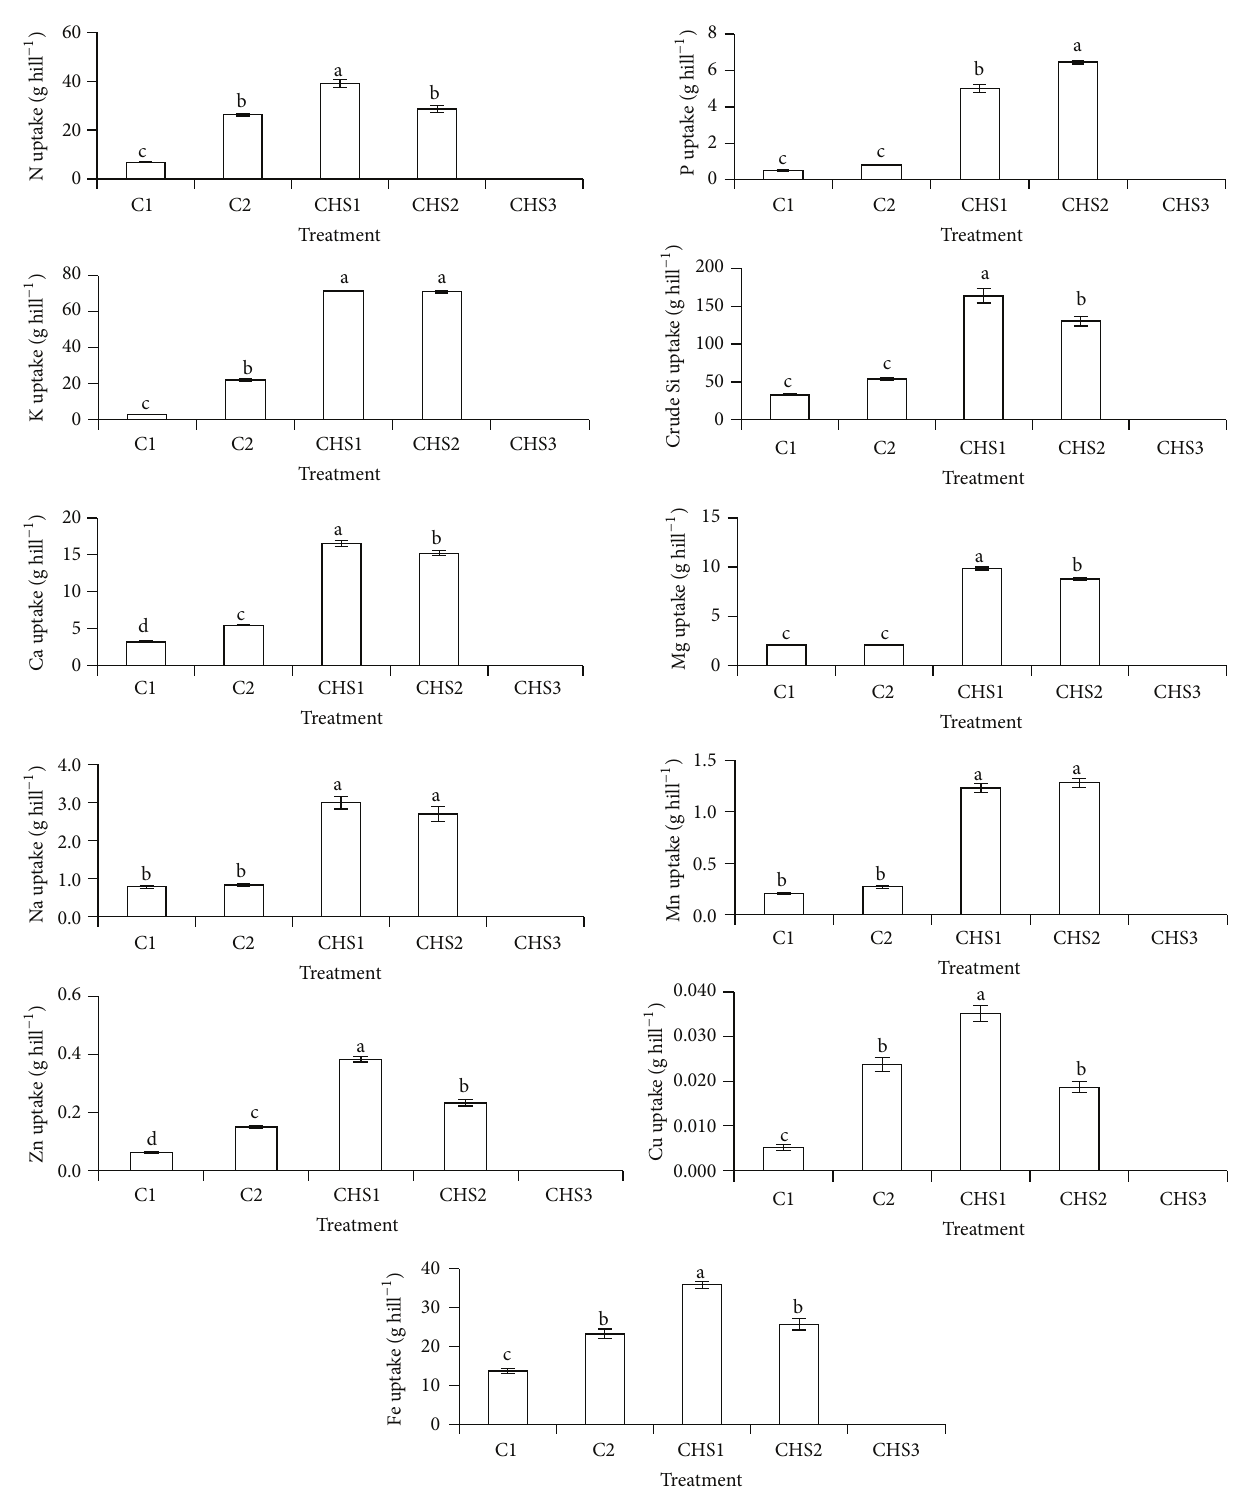
Figure 5: Treatments (C1: soil alone, C2: soil + complete fertilization, CHS1: soil + complete fertilization + 20 g rice straw compost + 2 g sawdust ash, CHS2: soil + complete fertilization + 40g rice straw compost + 4g sawdust ash, and CHS3: soil + complete fertilization + 60 g rice straw compost + 6 g sawdust ash) effect on N, P, K, crude silica, Ca, Mg, Na, Cu, Zn, Mn, and Fe uptake of rice plant at 90 days after seeding. Different alphabets indicate significant difference between means using Tukey’s test at 𝑃 ≤ 0.05 . The error bars are the ± standard error of